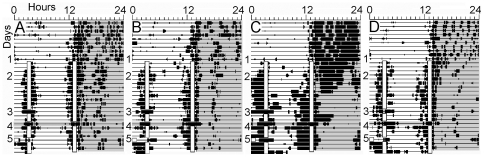
Wheel running activity of four representative rats in Experiment1.Each line represents 24 h, with time of day plotted left to right in 10 min bins. Time bins during which wheel counts were registered are denoted by heavy bars. Meals are indicated by opaque bars. Experimental conditions are numbered to the left of each panel: 1 = 37-h food deprivation, 2 = restricted feeding days, 3 = meal 1 omitted, 4 = both meals omitted in constant dark, 5 = meal 1 provided 3-h early.